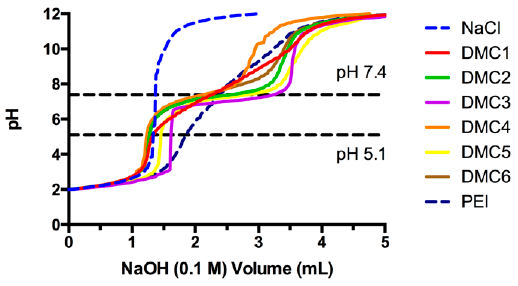
Figure 1. Titration curves of poly(amino ether)s by NaOH (0.1 M) from pH 2–12. PEI (branched, 25 kDa) and NaCl (150 mM) are included as references.